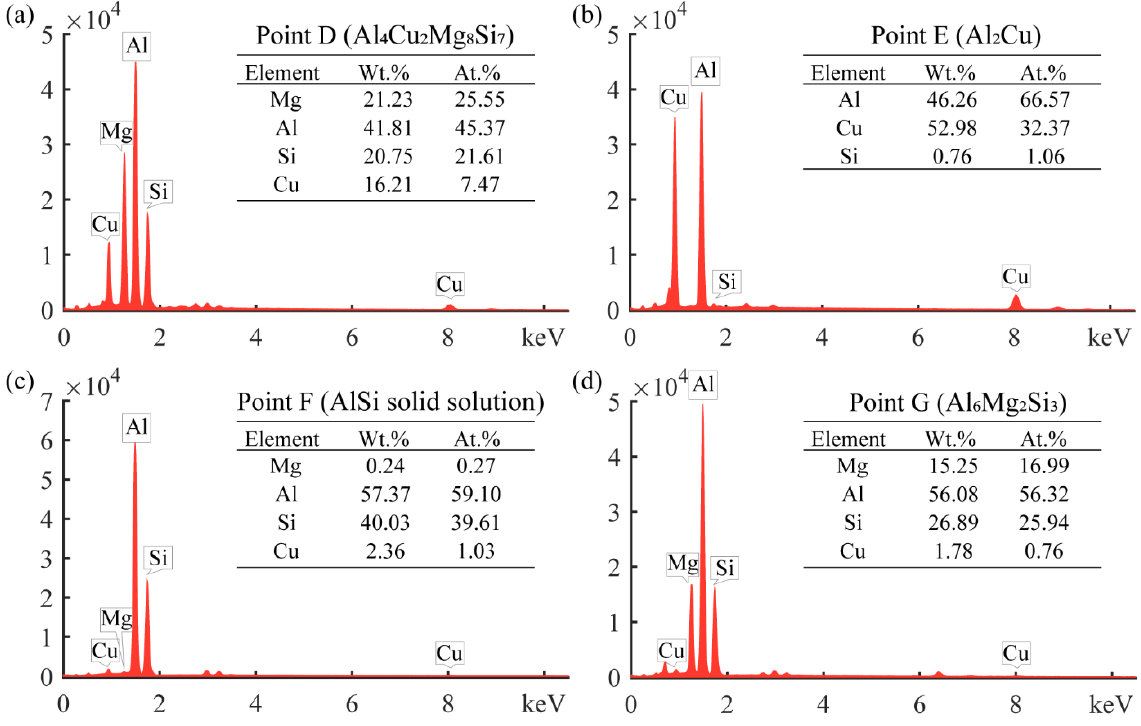
Figure 8. SEM micrograph of the metallurgical composite layer: ( a ) area Ⅰ , ( b ) area Ⅱ , ( c ) area Ⅲ , ( d ) area Ⅳ .